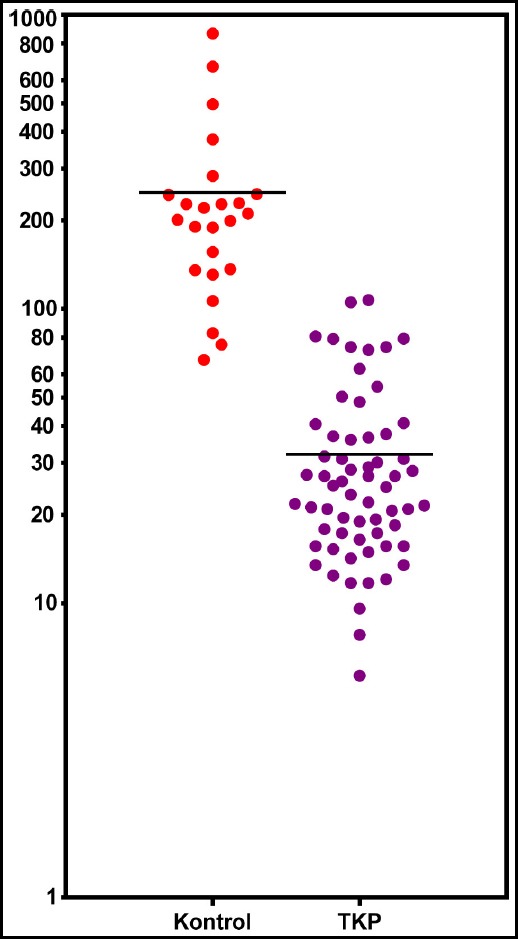
The distribution of serum endocan levels (pg/ml) in control and CAP patients (y axis is logarithmic)